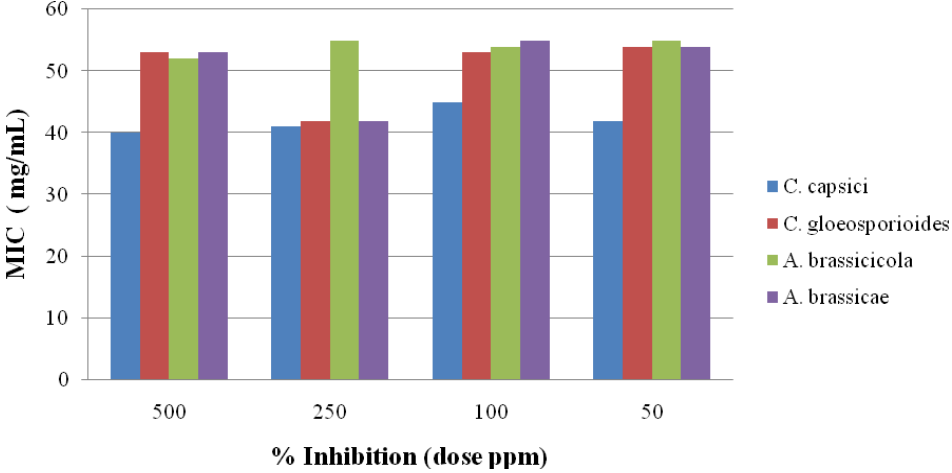
Positive control: fluconazole; negative control: DMSO.